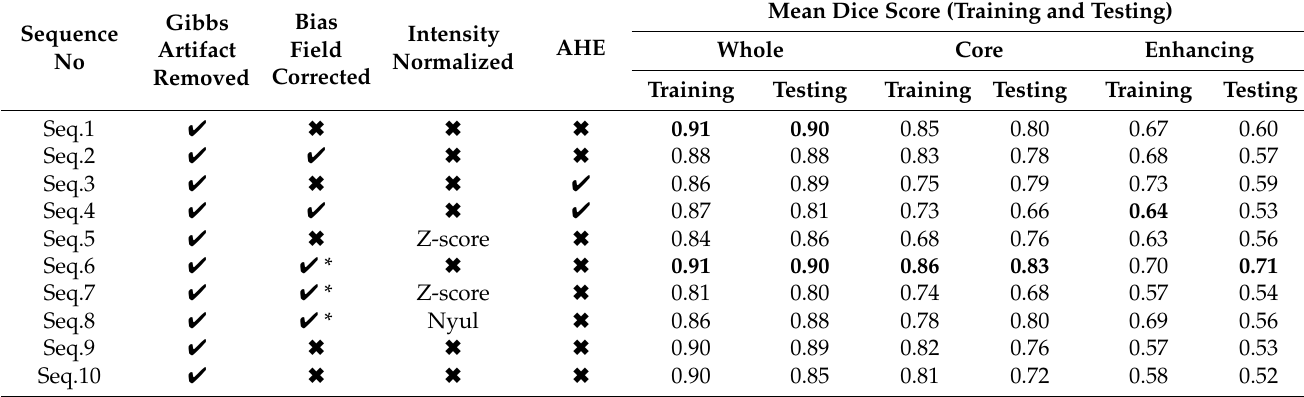
Table 2. Total sequences investigated in this work along with the training and testing dice scores. Sequence-1 to sequence-8 performed on BraTS-2018 while sequence-9 and sequence-10 performed over BaTS-2015 an BraTS-2013, respectively. * shows that this technique was employed as pre-processing technique prior to the Gibbs ringing artifact removal technique.